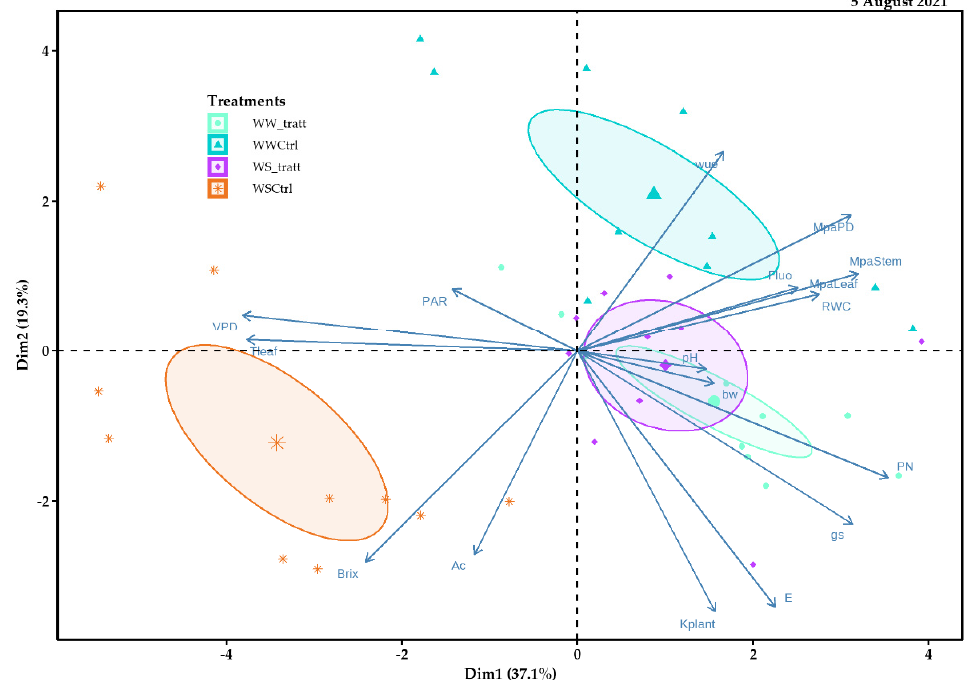
Figure 12. Relationship between principal component 1 (Dim1) and principal component 2 (Dim2) for response variables analyzed in field experiments with Pinot Noir cultivar subjected to different treatments (WWt, WW, WSt, and WS) during the 2021 season (5 August 2021). Principal component 1 (Dim1) of the 13 August 2021 explained 31.6% of the data var- iability and allowed for visualizing different treatment behaviors (delimited by different colored ellipses) in comparison, carried out based on the response variables. The WWt and WWCtrl treatments were similarly distributed to the left of the spatial distribution; they were negatively related to ecophysiological variables such as PN, gs, E, and KPlant, and positively related to technological parameters such as °Brix, pH, and Ac. While the WSCtrl treatment was positioned to the right of the spatial distribution. Instead, principal component 2 (Dim2) explained 14.1% of the data variability (Figure 13).